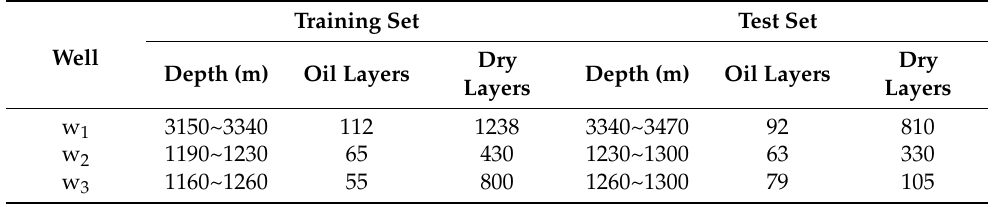
Table 2. Detail of logging